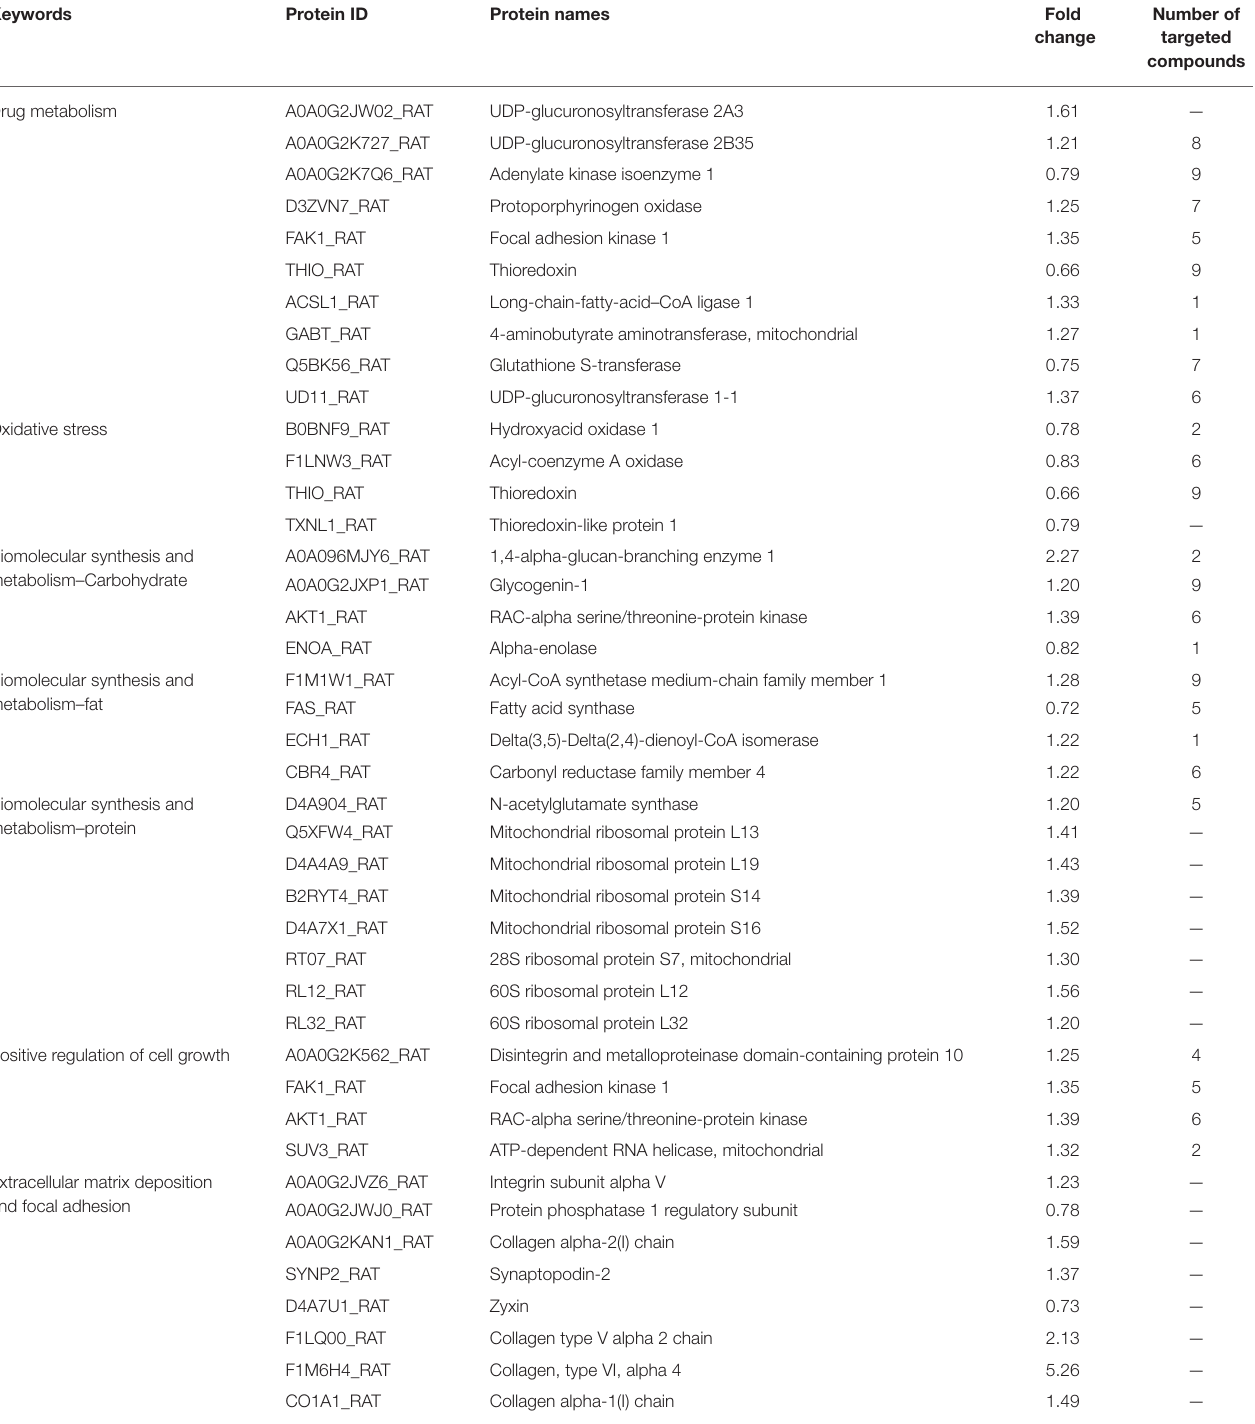
TABLE 1 | List of the altered proteins of DMN-model and H-ZYCH